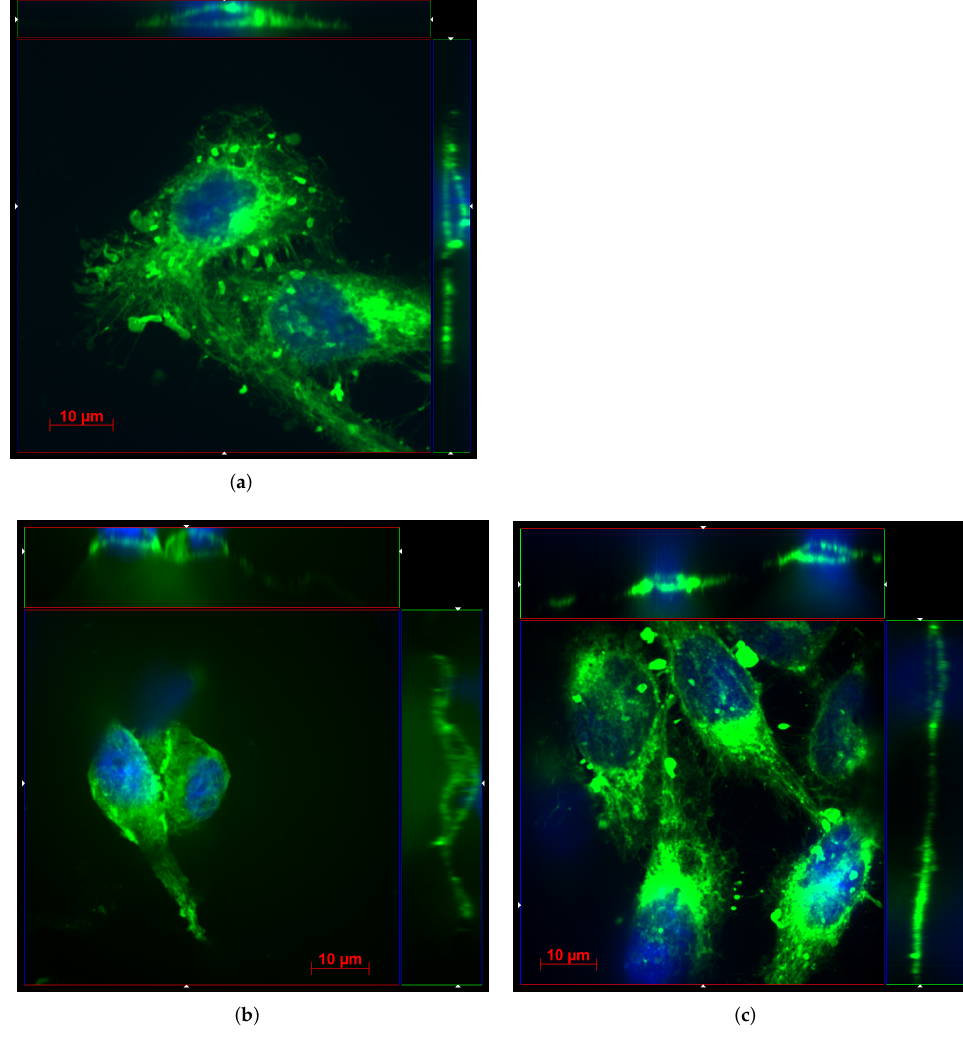
Figure 8. Confocal tomography images of the HeLa cells seeded on top of glass ( a ), Cu ( b ), and Cu–Ru ( c ) electrodes. Here, the red lines are referred to x axis, the green lines correspond to the z axis, and the blue lines refer to the y axis. The ends of cut-lines are marked by white triangles. One can see that the HeLa cells on top of Cu-based electrodes ( b , c ) have a fusiform shape similar to those observed on glass ( a ). Moreover, they duplicate the morphology of the electrodes, meaning that Cu-based electrodes are